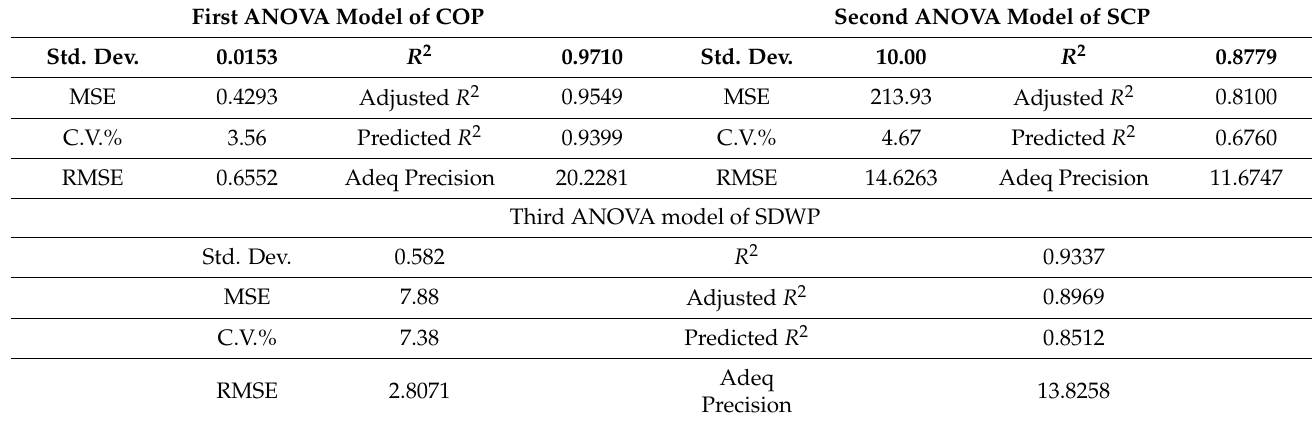
Table 4. Statical analysis of the ANOVA